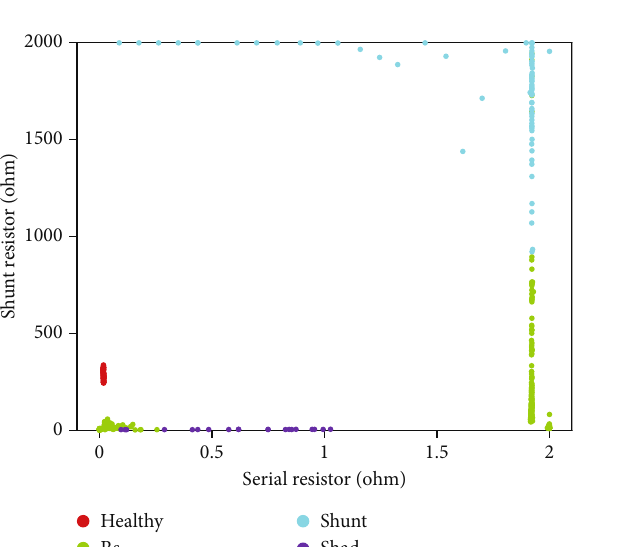
Figure 12: Distribution of data according to R